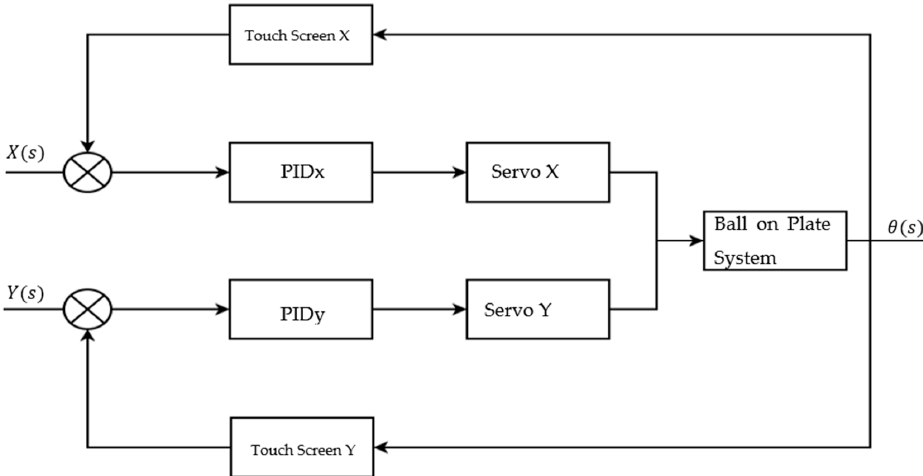
Figure 14. PID control system design.